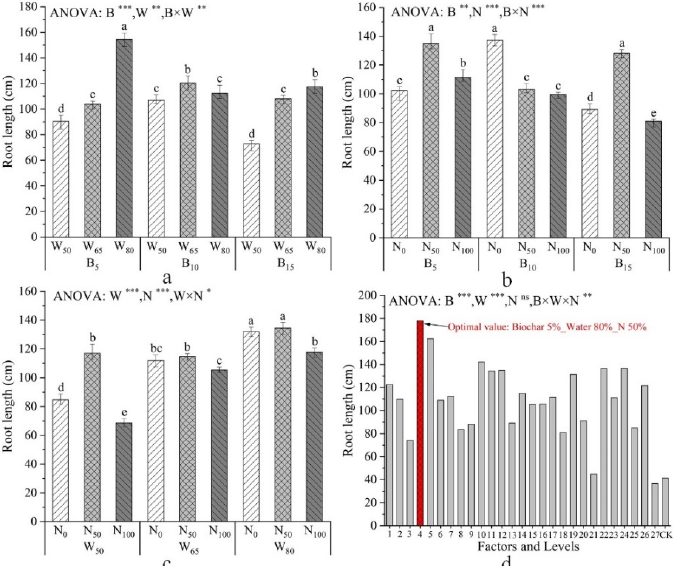
Figure 1. Effects of the total root length with different treatments of seedlings: ( a ) Interaction between biochar and water content; ( b ) Interaction between biochar and N; ( c ) Interaction between water content and N; and ( d ) Interaction between biochar, water, and N. Note: The implication of the 27 numbers and CK on the x –axis in the Figure is explained in Supplementary Table S1; values with different lower case letters were used in the same picture to indicate the significance of the difference when p < 0.05; *** ( p < 0.001), ** ( p < 0.01), * (0.01 < p < 0.05) were used to indicate whether there was remarkable difference between different treatments. The same as